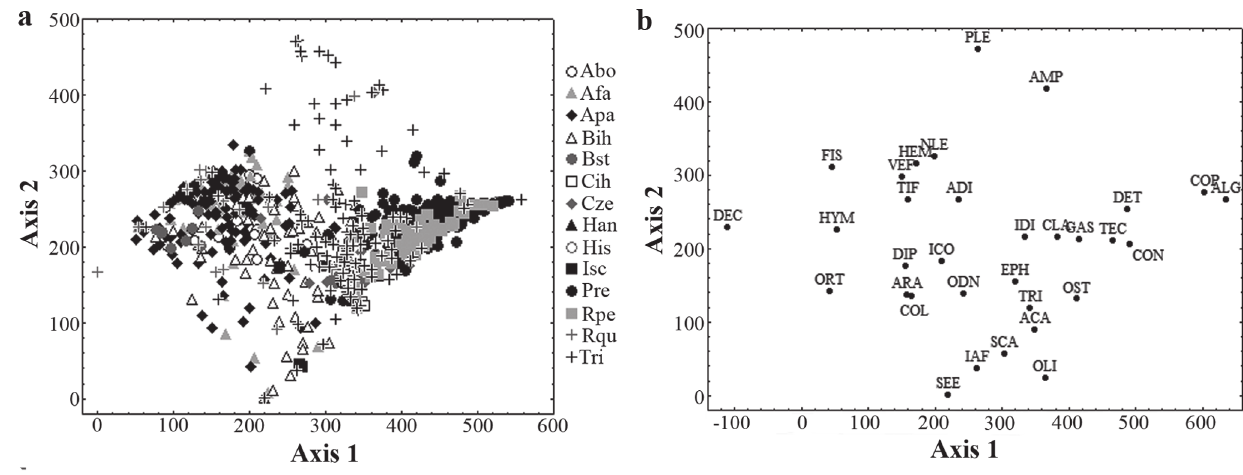
Fig. 2. Ordination of species ( a ) and food items ( b ) in Itiz stream, Ivaí River basin, Paraná State, Brazil, along the axis derived from Detrended Correspondence Analysis (DCA). See Table 2 for names of fish species. ACA = Acarina; ADI = Adult Diptera; ALG = Algae; AMP = Amphipoda; ARA = Araneae; CLA = Cladocera; COL = Coleoptera; CON = Conchostraca; COP = Copepoda; DEC = Decapoda; DET = Detritus; DIP = Diplopoda; EPH = Ephemeroptera; FAI = Aquatic insect remains; FIS = Fish; FTI = Terrestrial insect remains; GAS = Gastropoda; HEM = Hemiptera; HYM = Hymenoptera; ICO = Immature Coleoptera; IDI = Immature Diptera; ILE = Immature Lepidoptera; ODN = Odonata nymph; OLI = Oligochaeta; ORT = Orthoptera; OST = Ostracoda; PLA = Plant remains; PLE = Plecoptera; SCA = Scales; SEE = Seeds; TEA = Testate amoebae; TRI =